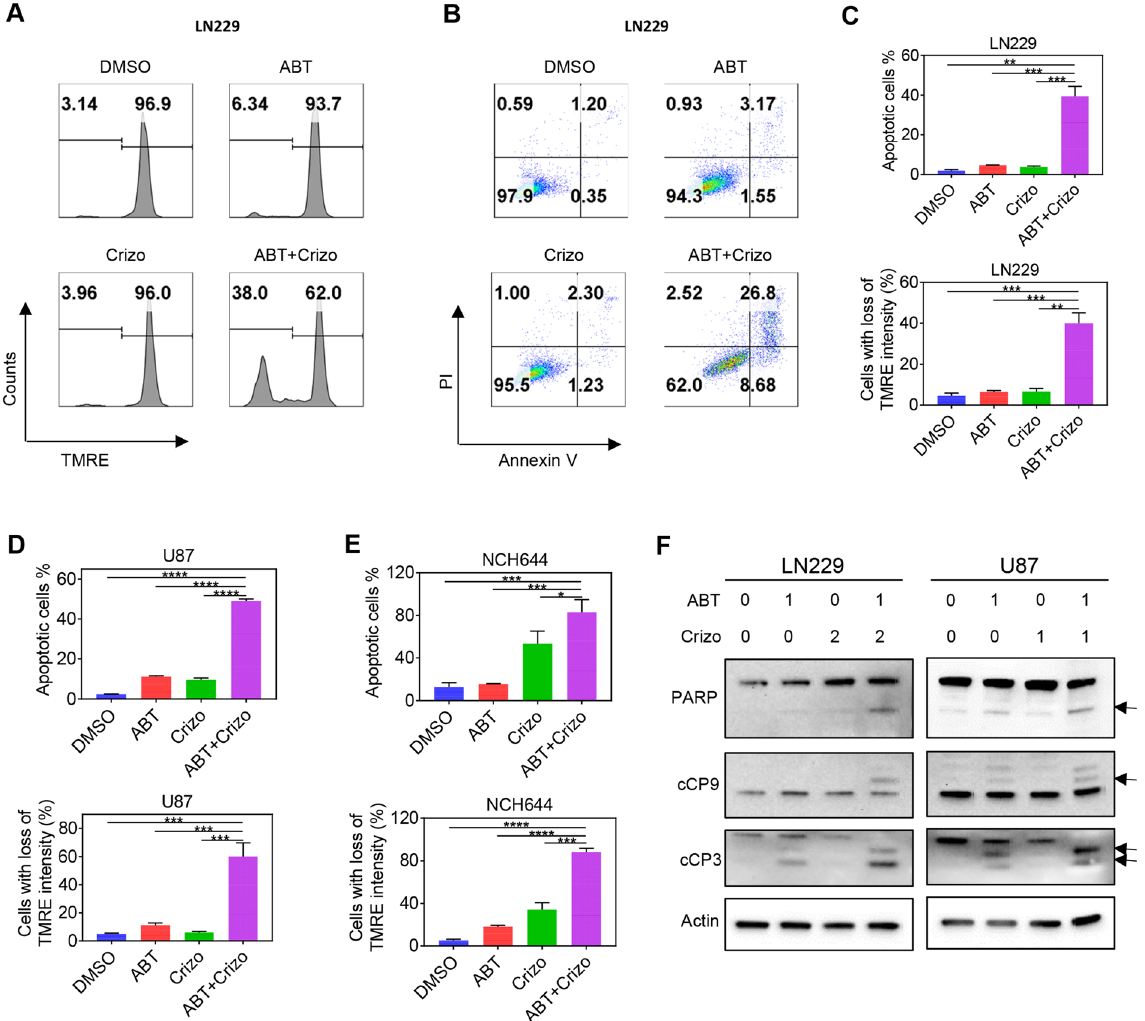
Figure 2. Enhanced apoptosis induction and dissipation of mitochondrial membrane potential by c-MET and Bcl-2/Bcl-xL inhibition. ( A) LN229 GBM cells were treated with ABT263 (ABT), Crizotinib (Crizo) or the combination of both and analyzed for mitochondrial membrane potential by TMRE staining with subsequent flow cytometry. ( B ) LN229 GBM cells were treated as in A, stained with Annexin V/propidium iodide and analyzed by multi-parametric flow cytometry. ( C–E ) Quantifications of Annexin and TMRE staining flow cytometric results in LN229, U87 and stem-like GBM cells. Shown are means and SD. n = 3. ( F ) LN229 and U87 GBM cells were treated with ABT263, Crizotinib (Crizo) and the combination treatment (1d). Whole cell protein lysates were prepared and analyzed by conventional Western blotting for the expression of PARP, cCP9 (cleaved caspase 9), cCP3 (cleaved Caspase-3). Actin serves as loading control. Arrows highlight the cleavage fragments of the respective proteins. Concentrations are in μ